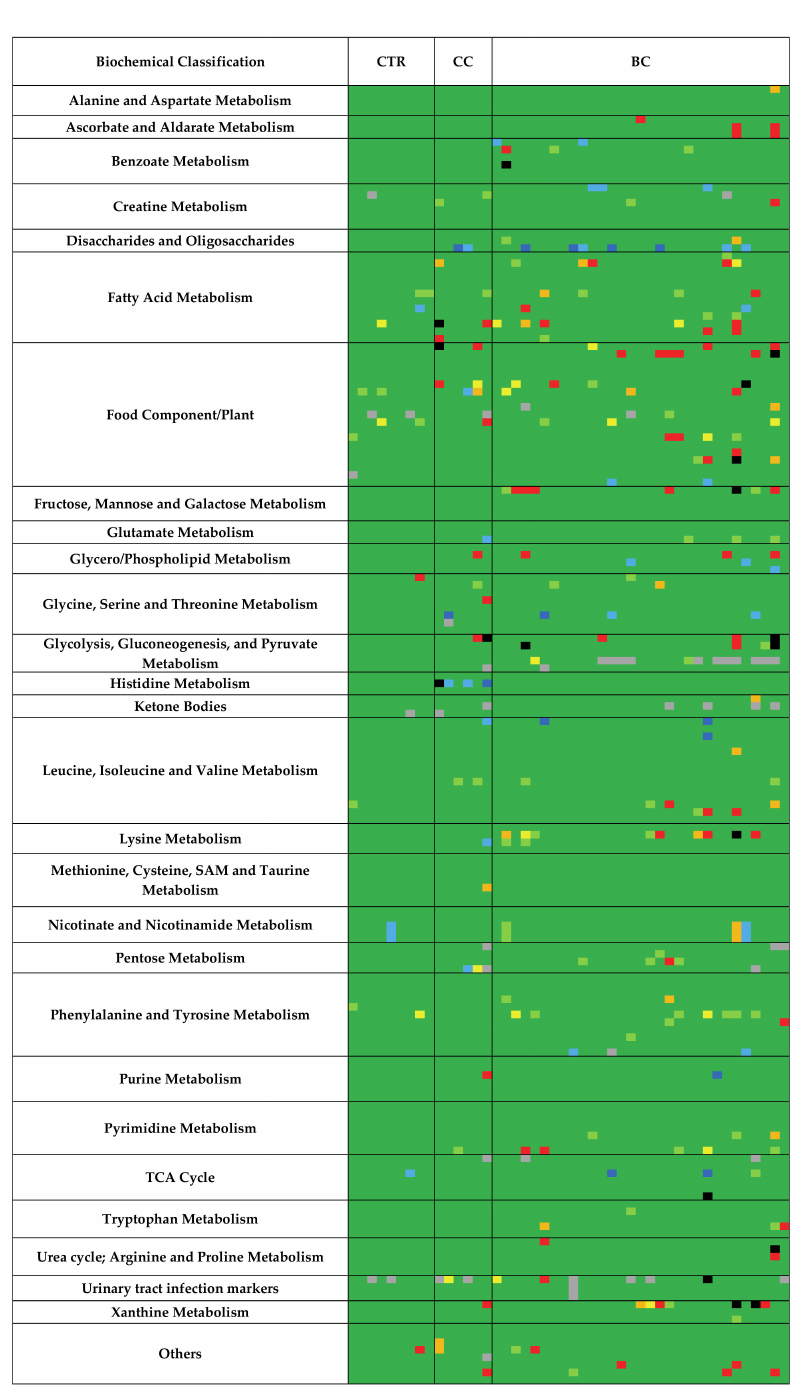
Figure 4. Heat map showing the general agreement between the ranges found in the literature and the concentrations in µ M/mM of creatinine for all biochemically classified metabolites in each urine sample belonging to CTR (Controls), CC (Chronic Cystitis), and BC (Bladder Cancer). Values in green lie within the range or exceed less than 5% of the limits; values in light green, yellow, orange, red, and black are those that exceed 5%, 20%, 35%, 50%, and 400%, respectively, of the maximum value; values in light and dark blue are those that are lower than 5% and 50% of the minimum, respectively. Cells in gray represent missing